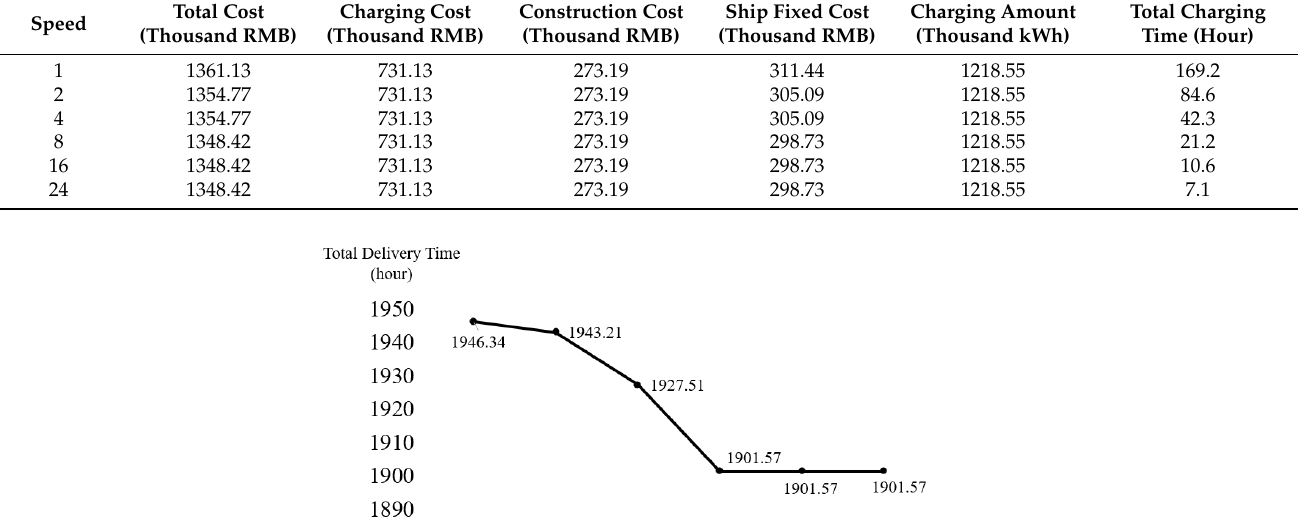
Table 10. The impact of charging speed.